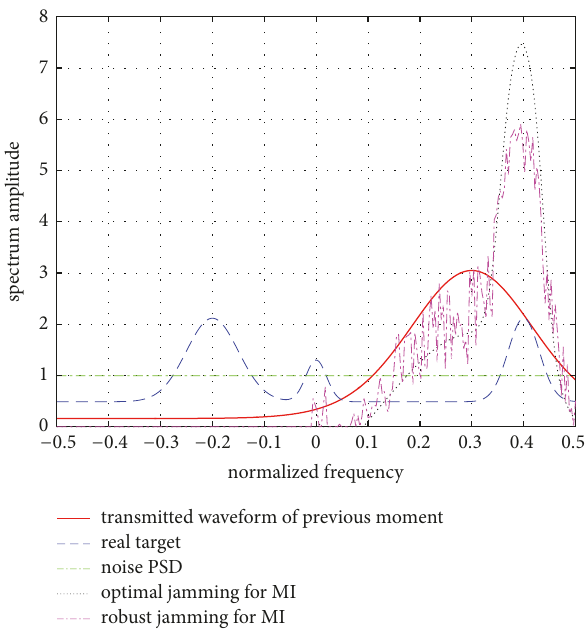
Figure 6: Jamming results for single target.